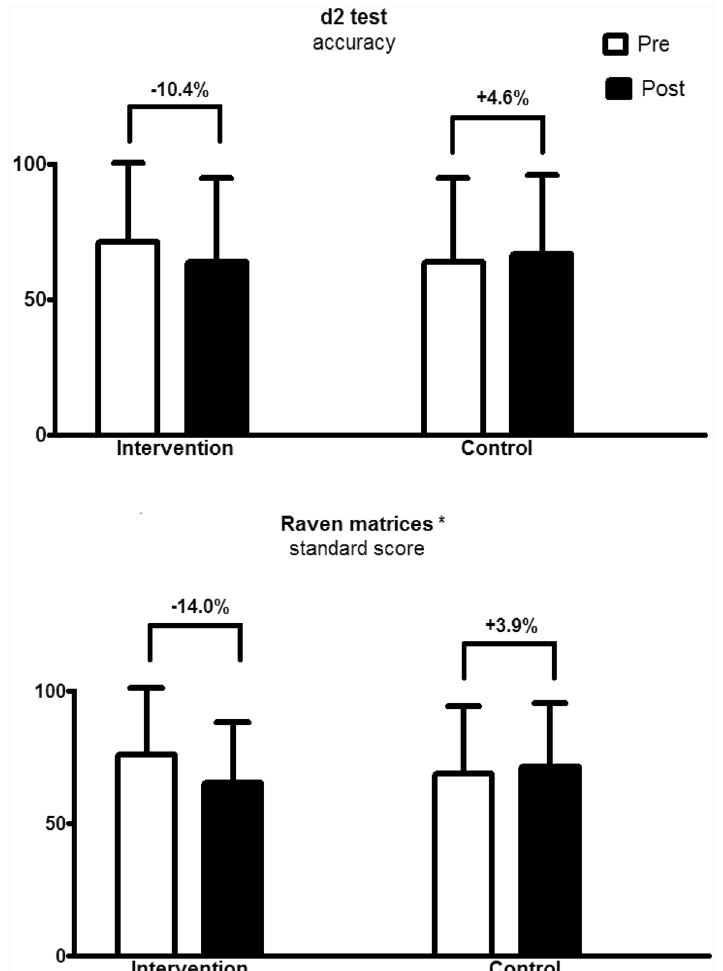
Figure 3. Relative changes in d2 test and Raven matrices performance pre and post 16 weeks. Data are expressed by the mean and standard deviation. Note : *Interaction group versus time ( p =